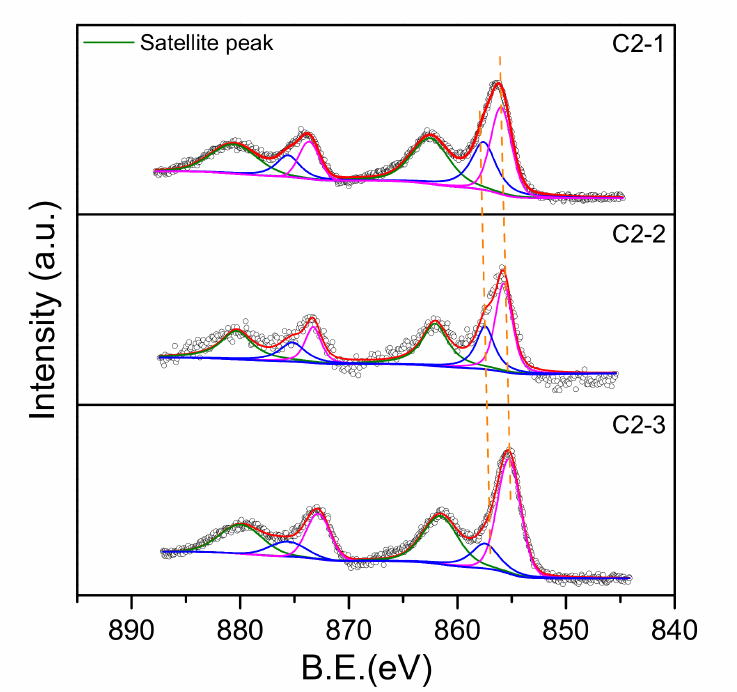
Figure 6. XPS spectra of NiZn / Al 2 O 3 with di ff erent Ni / Zn ratios after calcination. (C2-1) 10Ni2Zn / Al 2 O 3 , (C2-2) 10Ni4Zn / Al 2 O 3 , and (C2-3) 10Ni8Zn / Al 2 O 3